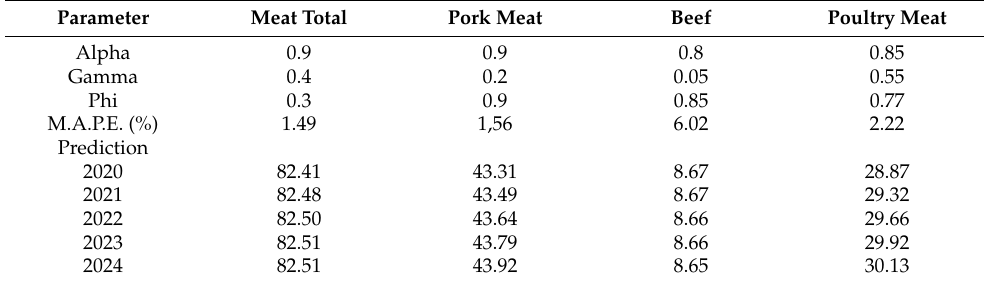
Table 4. Parameters of prediction models including forecasts of meat consumption for the years